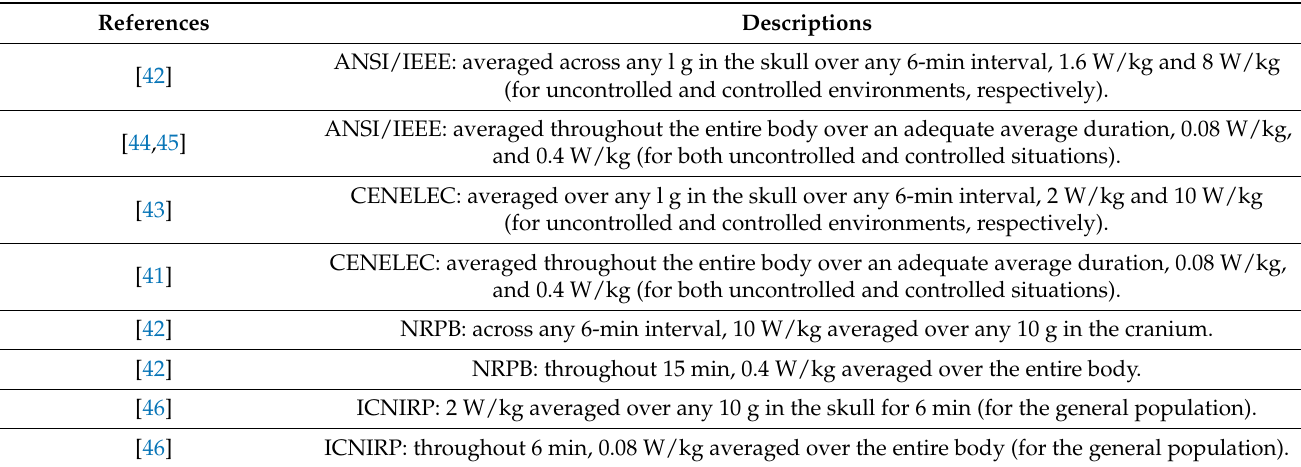
Table 1. Summaries of the SAR limits for four main safety